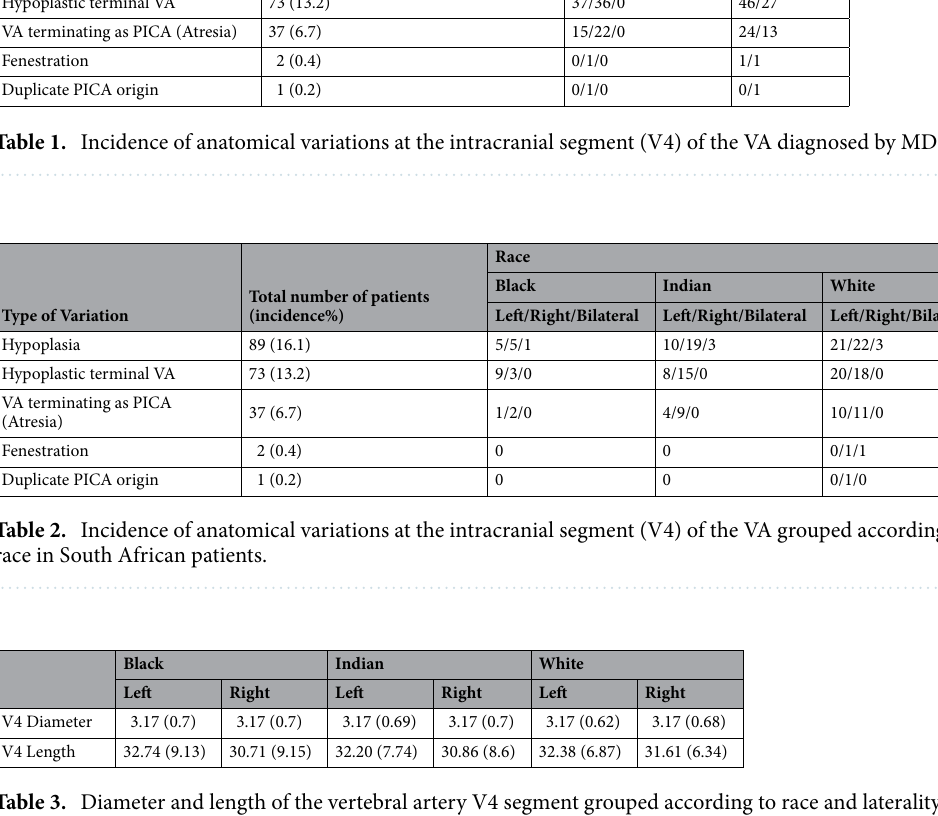
Table 3. Diameter and length of the vertebral artery V4 segment grouped according to race and laterality in South African patients. Results are reported as median ( IQR interquartile range) mm.